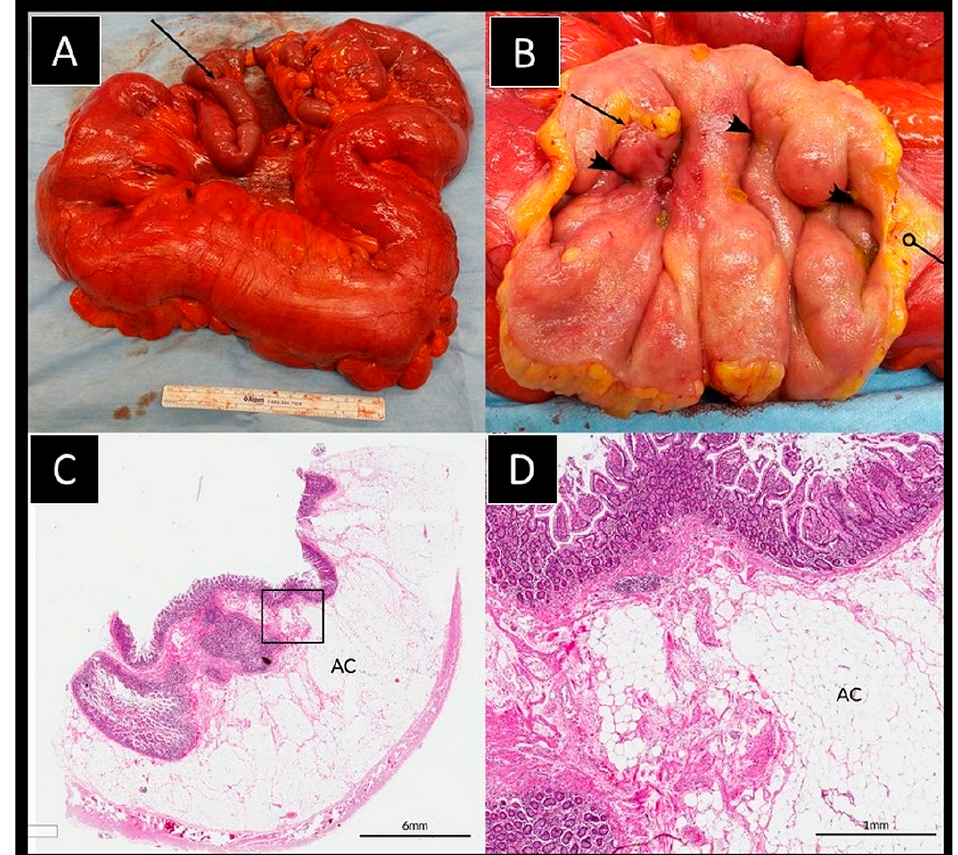
Figure 2. ( A ) Gross morphology (macroscopic appearance) of the resected segment of thickened and dilated ileum. This affected segment contrasts with the margin of normal calibre small bowel (arrow). ( B ) The intraluminal macroscopic morphology of the resected intestinal segment revealed by a longitudinal incision. This demonstrated diverticula (arrowheads), area of mucosal ulceration (arrow), and mural thickening consisting of bulging yellow fat of submucosal lipomatosis (circle pointer). ( C ) Low-powered photomicrograph of hematoxylin- and eosin-stained sections. This demonstrates infiltration of the thickness of the small bowel wall with numerous adipocyte cells (AC). ( D ) High-powered photomicrograph of hematoxylin- and eosin-stained sections. Magnification of the boxed area from panel C confirms the submucosal location of the adipocyte (AC) infiltration. benign submucosal lipomatosis with no evidence of malignancy (Figure 2C,D). The